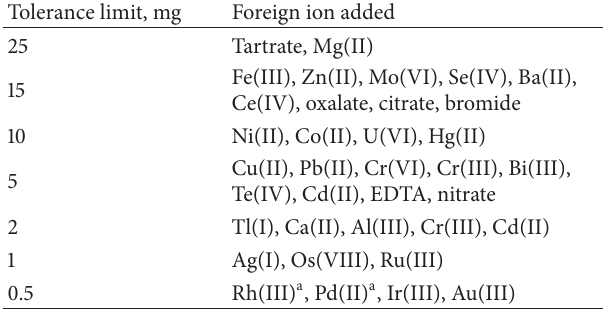
Table 5: Effect of foreign ions on the extraction of